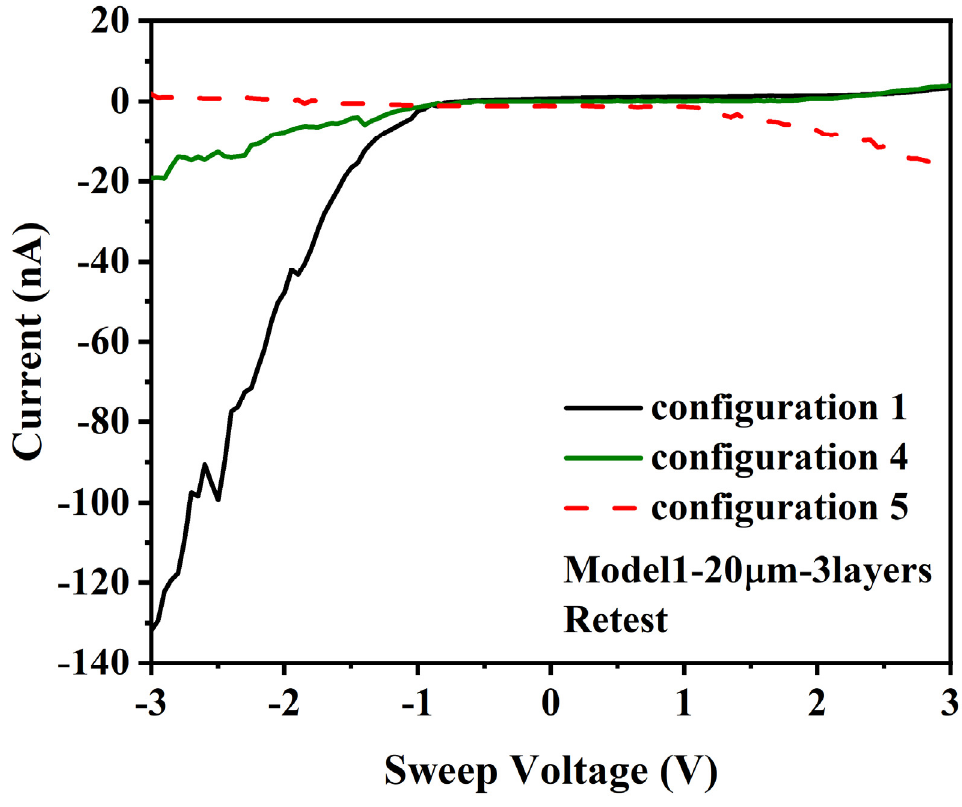
Figure 7. Retest I/V curve for 20 µm gap, 3 layers, and voltage applied to: (configuration 1) A1, B1-B3 grounded; (configuration 4) A1, B3 grounded, B1 and B2 float; (configuration 5) B1-B3, A1 grounded.